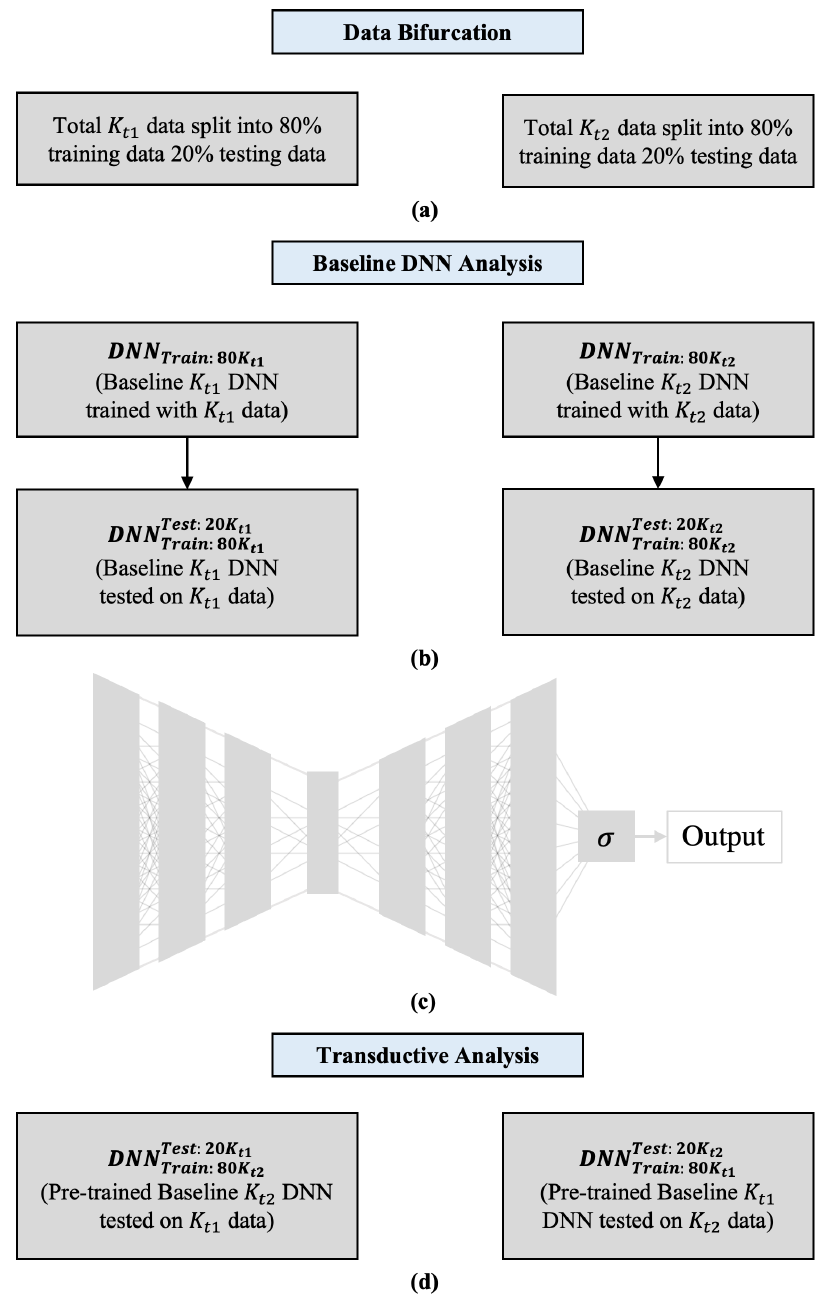
Figure 10. ( a ) Training and testing dataset bifurcation independently for K t 1 and K t 2 . ( b ) Baseline DNN training and testing with respective datasets for both K t s. ( c ) Baseline DNN architecture. ( d ) Transductive analysis—evaluating pre-trained DNNs in ( b ) by switching the test datasets for each K t